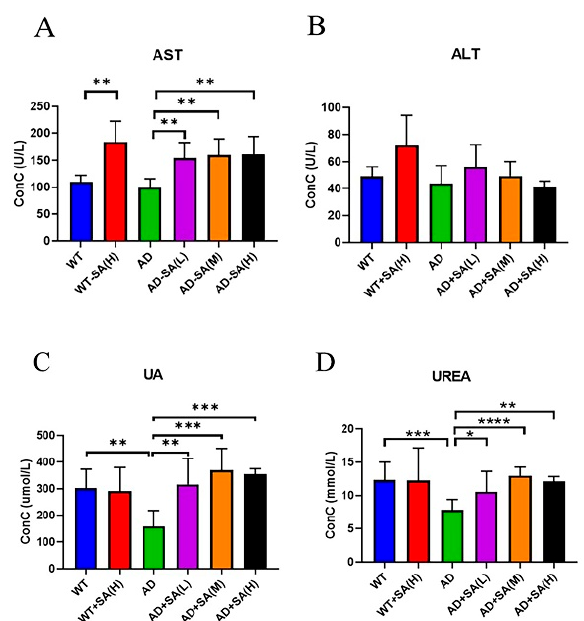
Figure 7. Effect of SA treatment on liver and kidney indicators in 2×Tg AD mice. ( A ) Aspartate transferase. ( B ) Alanine aminotransferase. ( C ) Uric acid. ( D ) Urea (* p < 0.05, ** p < 0.01, *** p < 0.001, and **** p < 0.0001). Student’s t test was used for statistical analysis. Error bars represent the mean ± SEM ( n = 6).